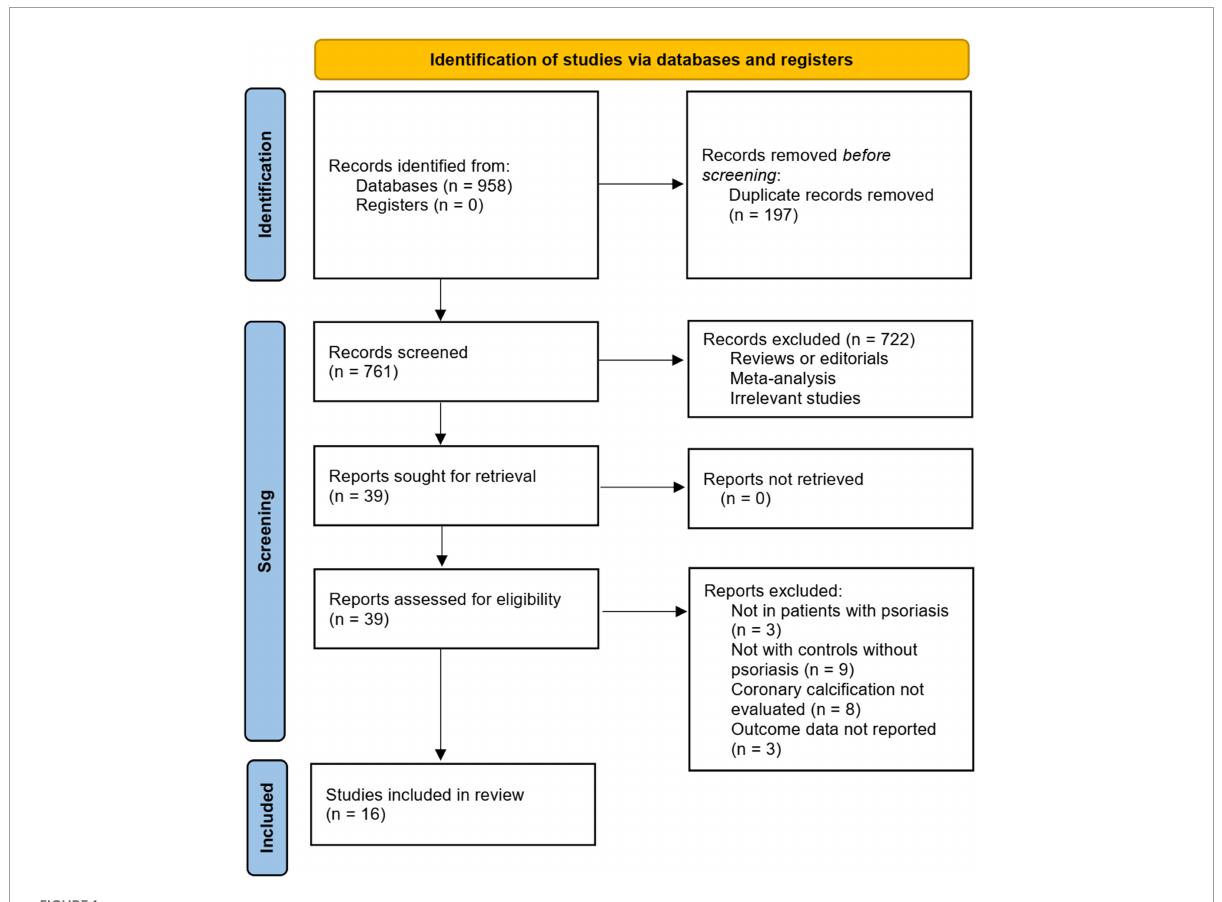
FIGURE1 Summary of the literature search and study identification